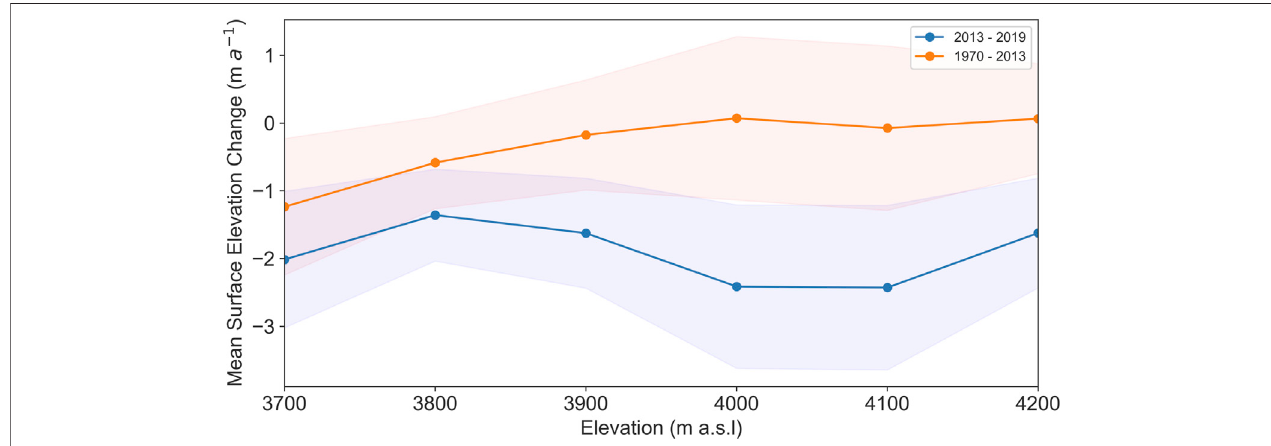
FIGURE5| ComparisonofmeanannualchangeinsurfaceelevationoverthelowerpartoftheablationareaofPonkarGlacier(3,700 m a s l.to4,200 m a s l.)between 1970 and 2013 (orange line) and 2013 and 2019 (blue line). The shaded uncertainty intervals correspond to one standard deviation per elevation bin. On average, surface elevation changes were approximately nine times more negative between 2013 – 2019 compared with 1970 – 2013 with the entire terminus now undergoing thinning.